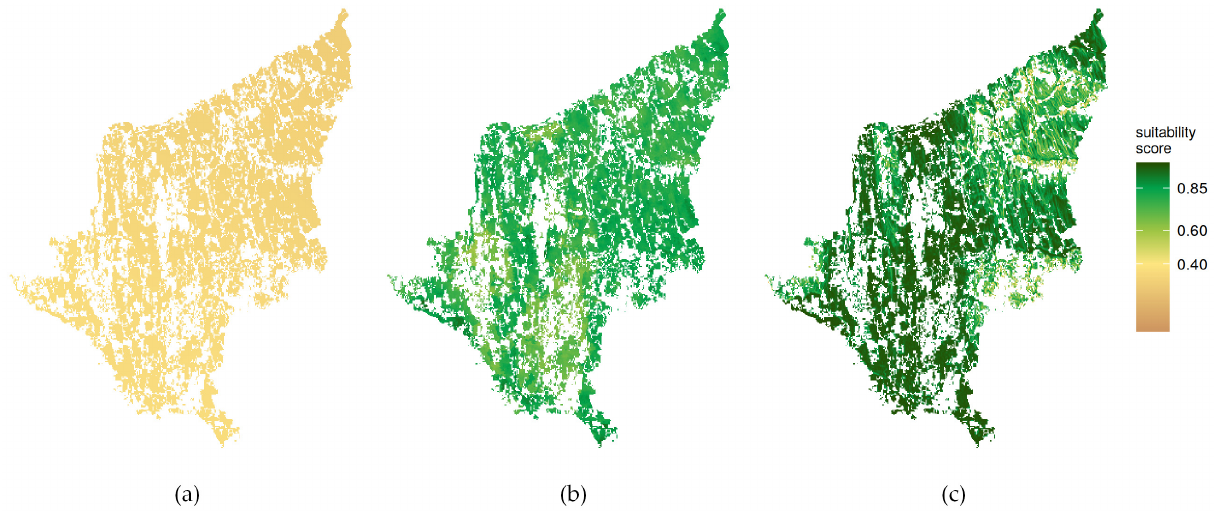
Figure 7. Suitability score maps of input parameters for maize in Somogy, where: ( a ) climatic factors; ( b ) soil factors; ( c ) topographic factors .